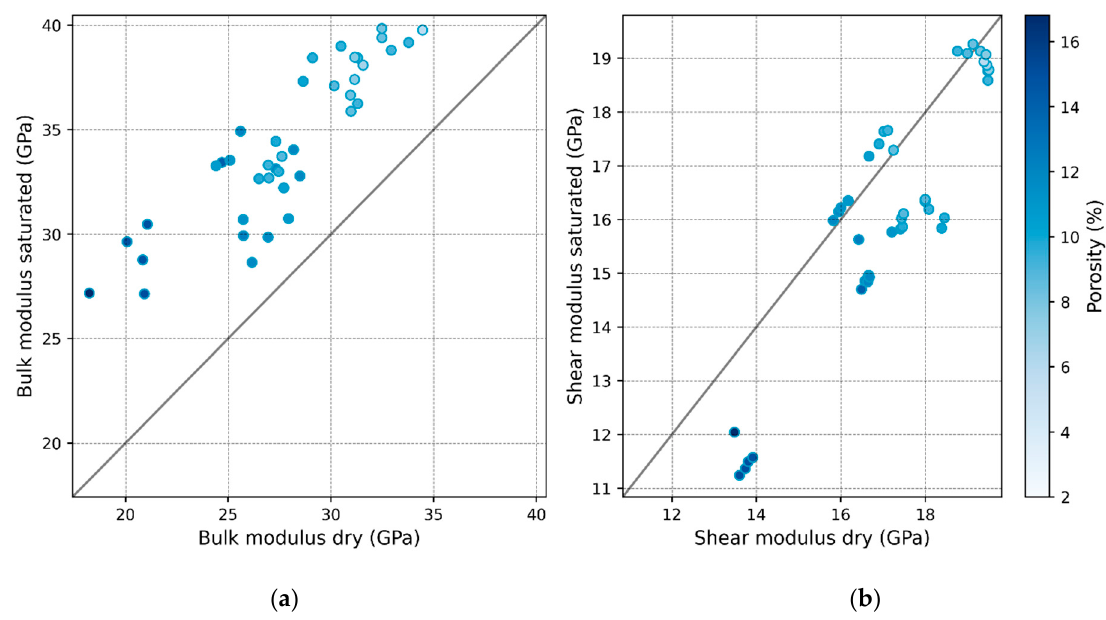
Figure 11. Crossplot of elastic moduli between dry and saturated samples: ( a ) bulk modulus and ( b ) shear modulus.